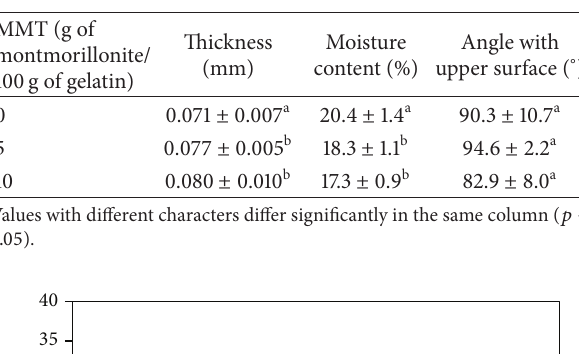
Table 1: Average thickness, moisture content, and contact angle of the films ( ± standard deviation) prepared with 5g of gelatin/100 g NFS and different MMT concentrations.